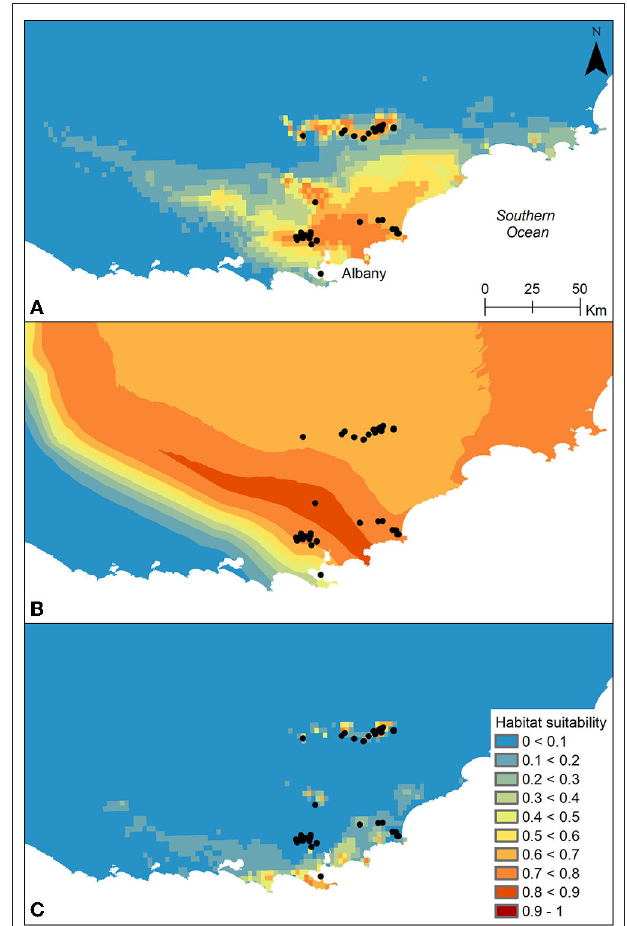
FIGURE 2 | Distribution models of Banksia brownii for (A) the present, (B) the last glacial maximum ( ∼ 21,000 years; average LGM model based on CCSM4 and MIROC-ESM) and (C) projected climate at 2070. Warmer colors indicate a higher probability of species presence, whereas colder colors indicate a lower probability of species presence. Records of B. brownii (extant and extinct) used for the modeling are represented in black circles in (A)